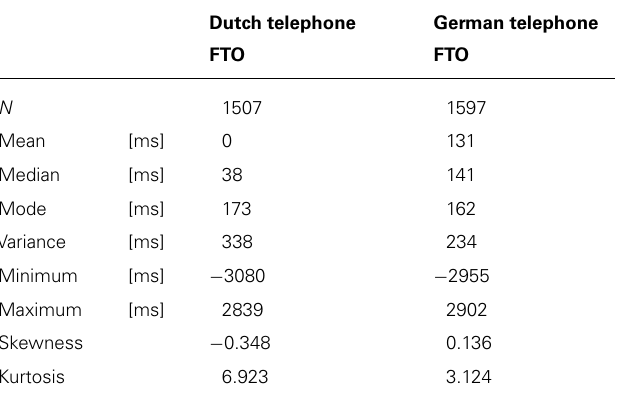
Table 1 | Comparison of Dutch and German telephone corpora.